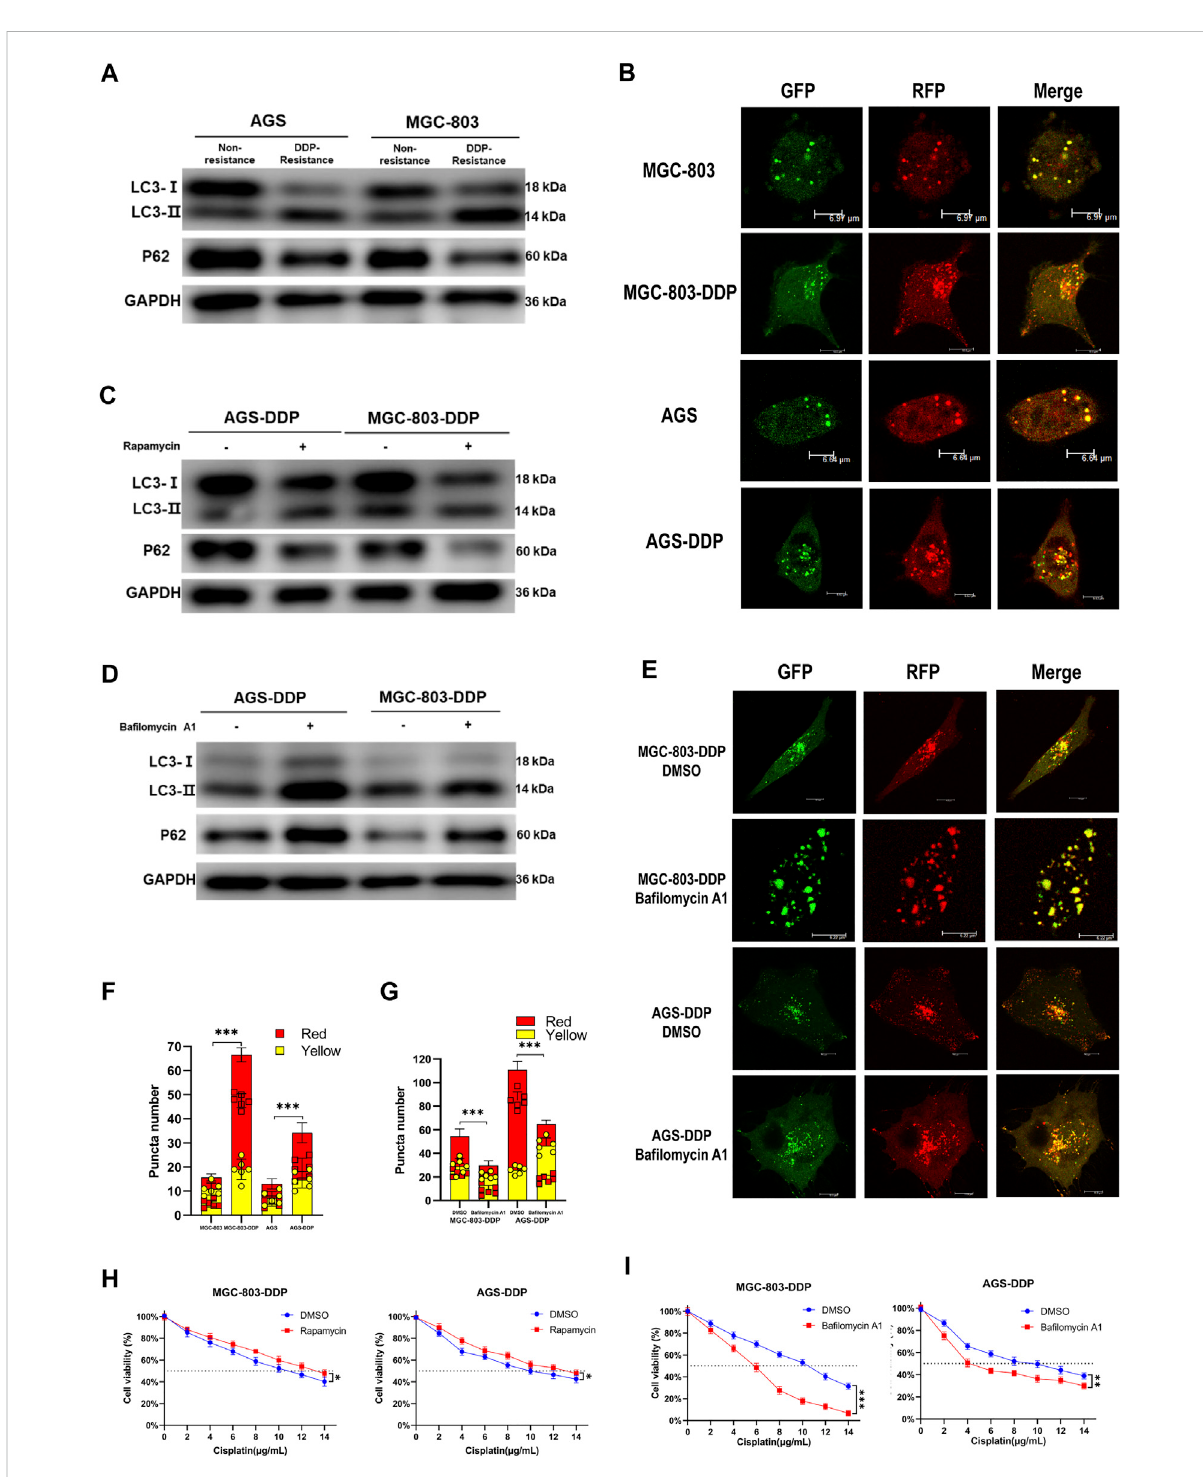
FIGURE 3 Autophagy contributes toDDP-resistance inGC. (A) Westernblotting ofautophagy-related proteinLC3 andp62 inAGS-DDP, MGC-803-DDP, and relative non-resistant cells. (B) Confocal microscopy showing the autophagy fl ux in AGS-DDP and MGC-803-DDP cells. (C) The effects of rapamycin on LC3-II and p62 levels. (D) The effects of ba fi lomycin A1 on LC3 and p62 levels. (E) The effects of ba fi lomycin A1 on autophagy fl ux in AGS-DDPandMGC-803-DDPcells. (F) StatisticalanalysisofredandyellowpunctanumberinAGS-DDPandMGC-803-DDPcellscomparedto non-resistant cells [cell image: (B) ]. (G) Statistics of red and yellow puncta number in AGS-DDP and MGC-803-DDP cells treated with ba fi lomycin A1 [cell image: (E) ]. (H) The effects of ba fi lomycin A1 on the IC50 of AGS-DDP and MGC-803-DDP cells. (I) The effects of rapamycin on the IC50 of AGS-DDP and MGC-803-DDP cells. Data are represented as the mean ± SD. * p ＜ 0.05. ** p < 0.005. *** p < 0.001. The experiments were repeated independently at least three